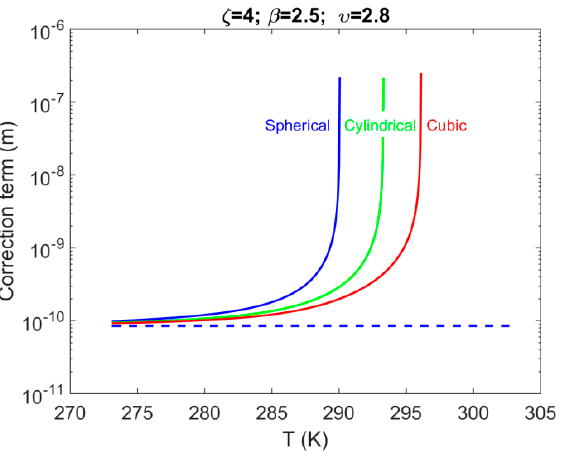
Figure 8. The correction term, r shift , as a function of temperature for porous system S1. The corresponding pressures are those along the three-phase (H–L w –V) equilibria line for the methane + water binary system.